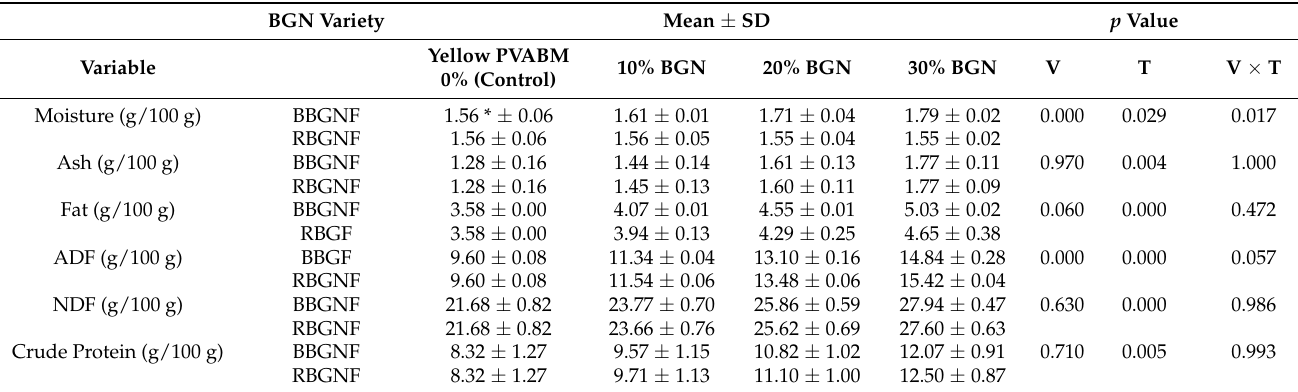
Table 6. The moisture, protein, fat, fiber and ash content of the BGN–PVABM composite complemen- tary instant porridges [dry basis (db)].